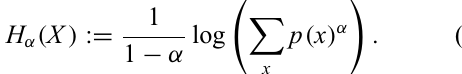
FIG. 1. Isoelastic utility function u R ( w ) (18) as a function of positive wealth (1 ≤ w ≤ 3) for players with different risk ten- dencies (different values of R ). The risk parameter R quantifies different types of risk tendencies: (i) R < 0 risk-seeking players (convex), (ii) R = 0 risk-neutral players (linear), and (iii) R > 0 risk-averse players (concave). Risk aversion for positive wealth then increases from −∞ to ∞